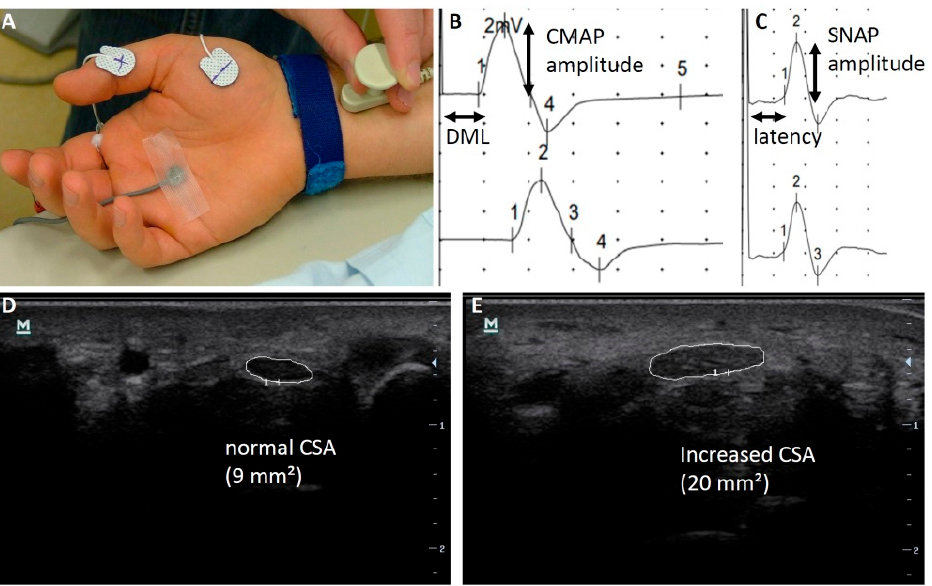
Figure 1. Nerve conduction studies and peripheral nerve ultrasound of the median nerve at the wrist. ( A ) Placement of electrodes. ( B ) Motor nerve conduction study. ( C ) Sensory nerve conduction study. ( D ) Normal cross-sectional area (CSA) of the median nerve. ( E ) Increased CSA of the median nerve. Abbreviations: CMAP, compound motor action potential; CSA, cross-sectional area; DML, distal motor latency; SNAP, sensory nerve action potential.